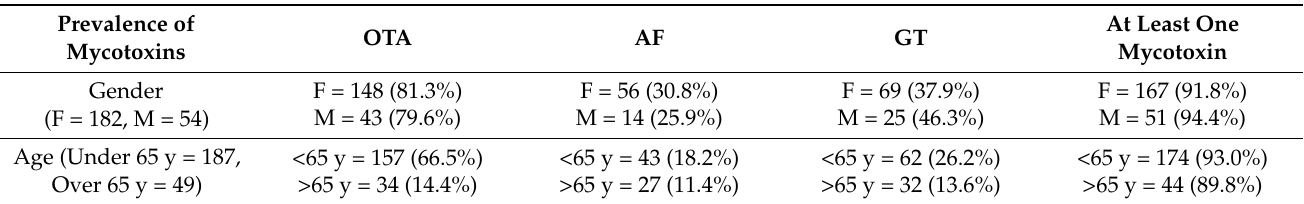
Table 1. Number of ME/CFS patients who tested positive for mycotoxins in urinalysis by gender and